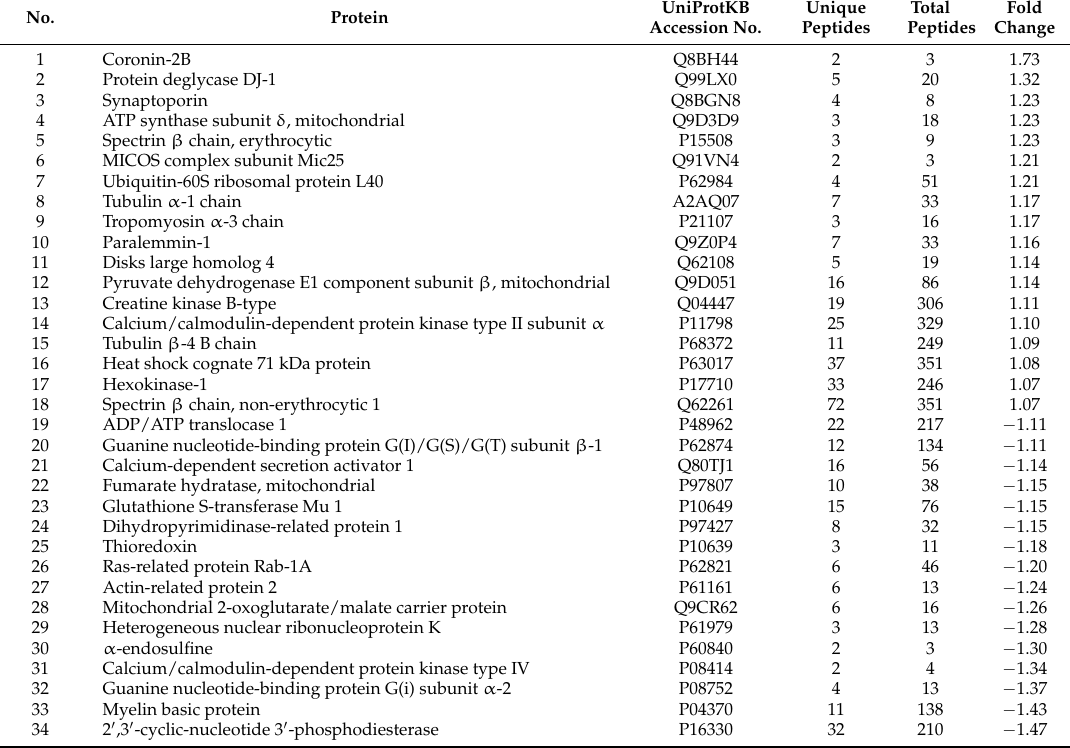
Table 5. Differentially expressed proteins in the frontal cortex mitochondria of Alda-1-treated apoE − / − group vs. untreated apoE − / − group ( p < 0.05, n = 3). No.